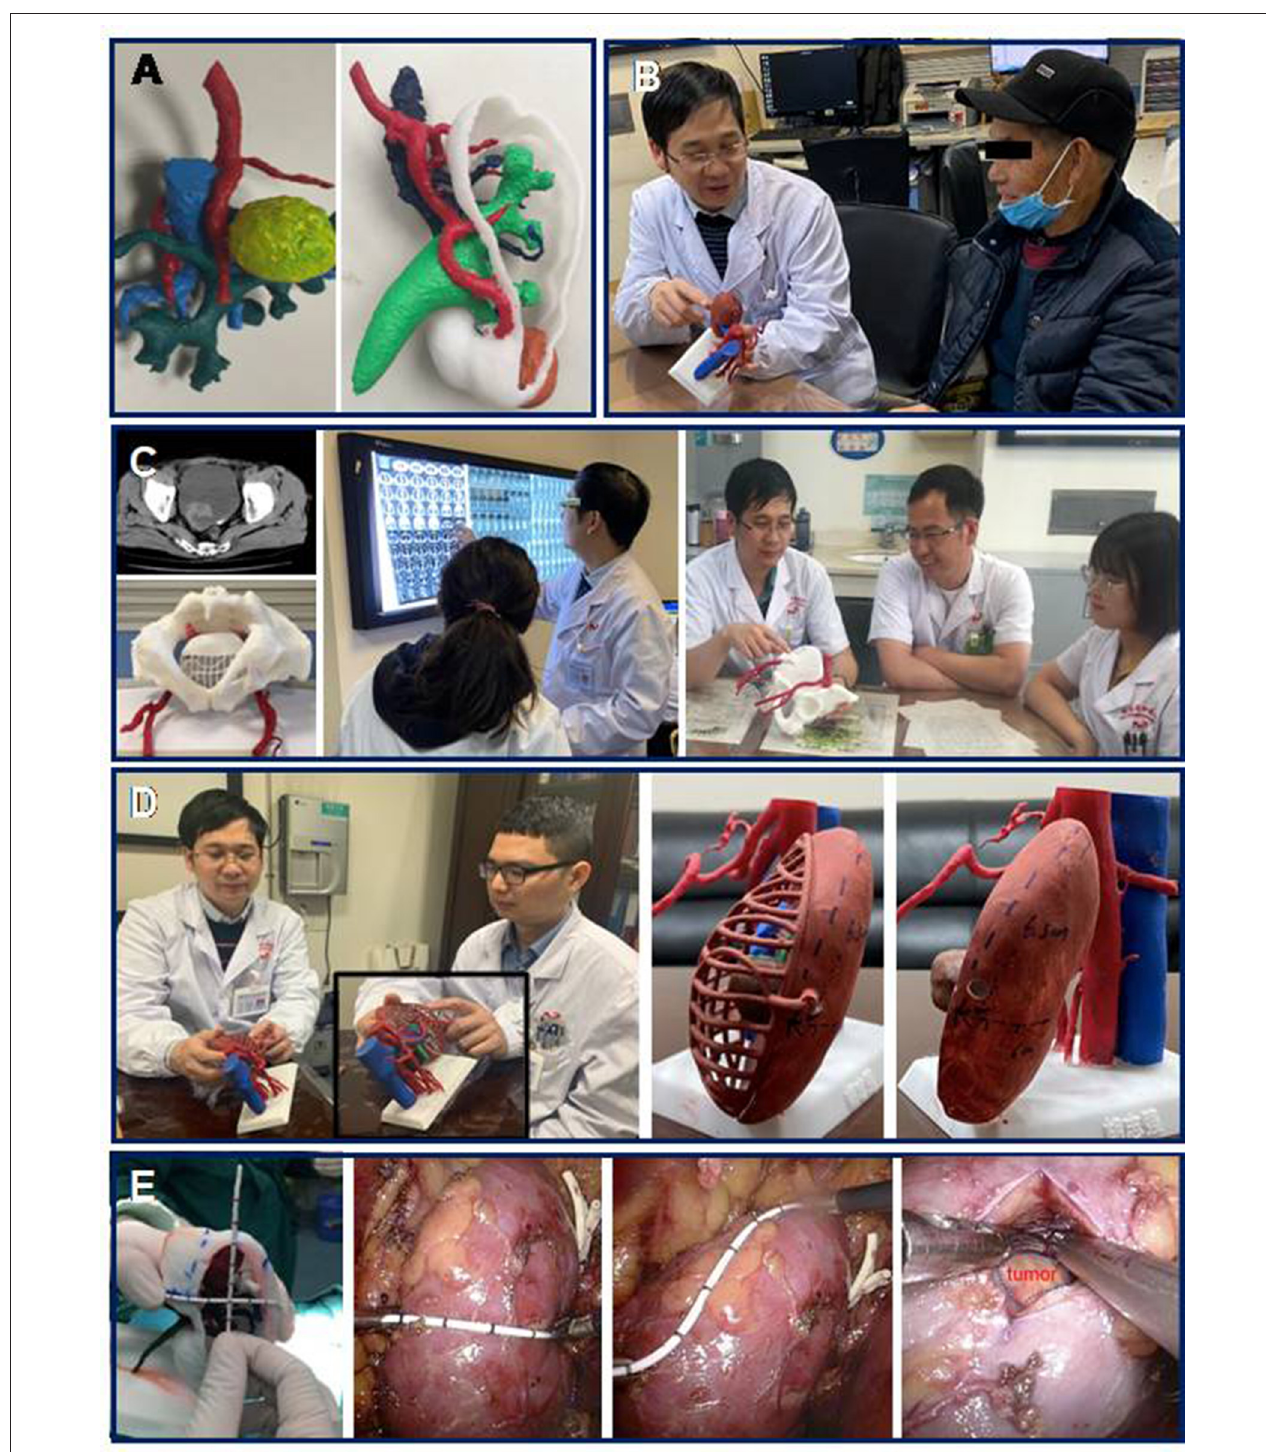
FIGURE 1 | 3D printing in clinical practices. 3D printing as an evolving technology enables the creation of patient-specific physical models with high precisionthat contribute to patient understanding, simulation training, as well as surgical planning and guidance. (A) 3D physical kidneymodels. (B) 3D-printed model in patient counseling. (C) 3D-printed model in anatomical and surgical education. Students were provided with 3D models during the training section. (D) 3D-printed model for preoperative planning. Surgeons discussed surgical planning and complexity, as well as potential complications, assisted by a patient-specific 3D model. Tumor markers are labeled on the surface of the models. (E) 3D-printed model for intraoperative guidance. 3D physical model utilisedin laparoscopic partial nephrectomy. Based on the makers on the surface of the kidney model, a renal mass can be quickly located with precise orientation.